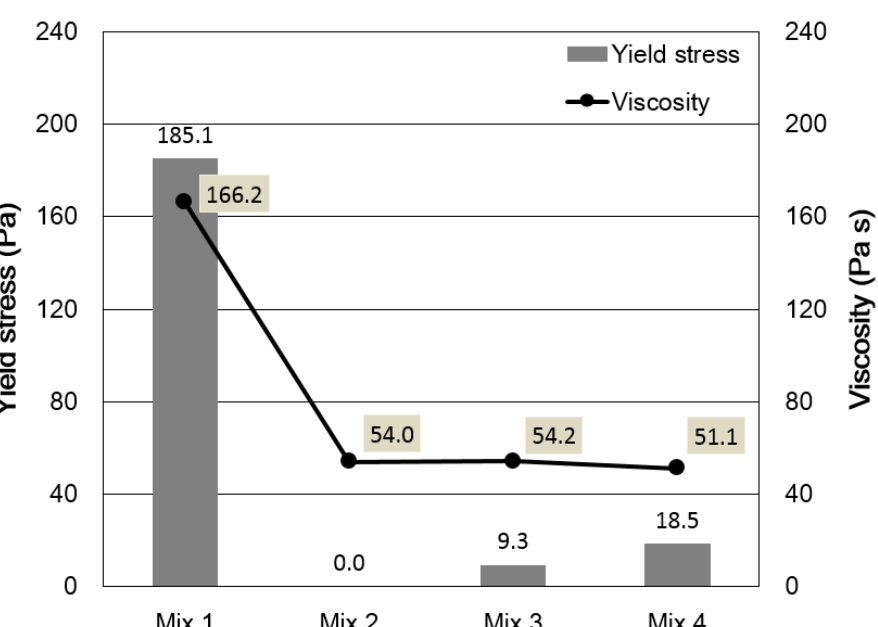
Figure 5. Flow test results.